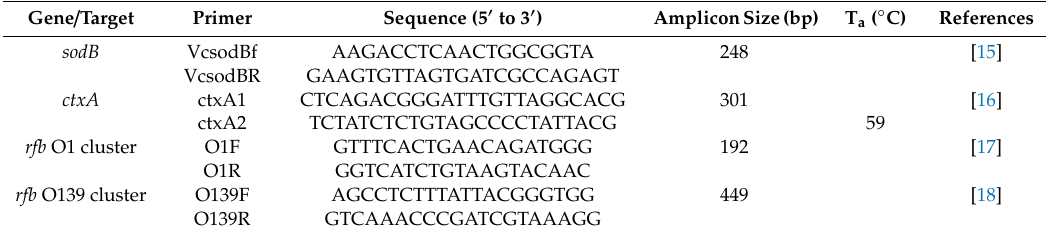
Table 2. Multiplex PCR for species ( sodB ), cholera toxin gene ( ctxA ) and serogroups O1 and O139 detection. Gene /